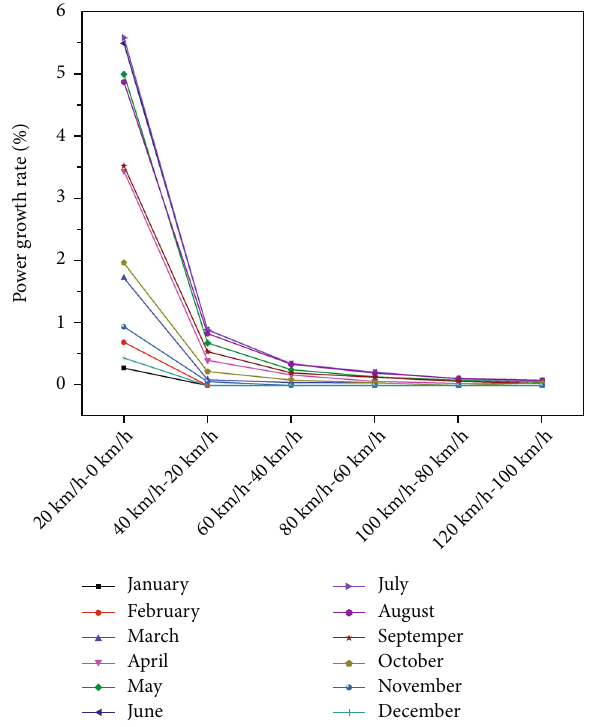
Figure 11: Power growth rate at di ff erent speeds in each month